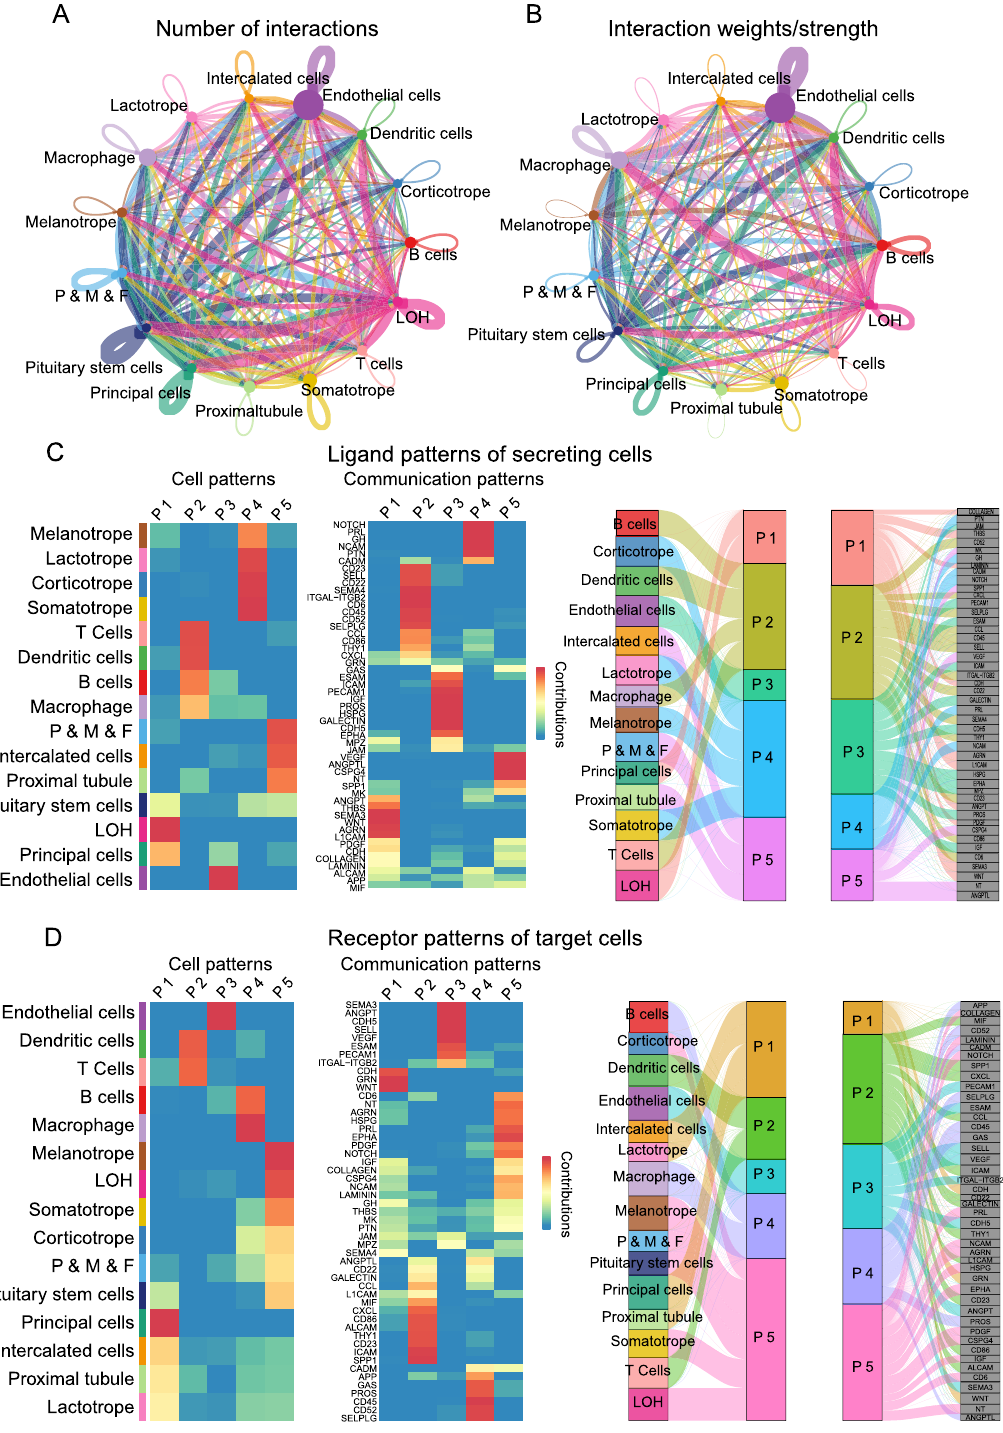
Figure 2. Exploration of the pituitary and kidney cell–cell interaction patterns. ( A ) Circle plot of the ligand– receptor pairs of all cell types, with the thickness of the string representing the number of ligand–receptor pairs. ( B ) Circle plot of the ligand–receptor pairs of all cell types, with the thickness of the string representing the weight of the ligand–receptor pairs. ( C ) Ligand patterns of each cell type, with each pattern representing a set of ligands that have similar properties. The color range represents the contribution scores of patterns or ligands (left panel), and the river plot shows the contribution of ligands to different patterns and the contribution of patterns to different cell types (right panel). ( D ) Receptor patterns of each cell type, with each pattern representing a set of receptors that have similar properties. The color range represents the contribution scores of the pattern or receptor (left panel), and the river plot shows the receptors that contribute to different patterns and the patterns that contribute to different cell types (right